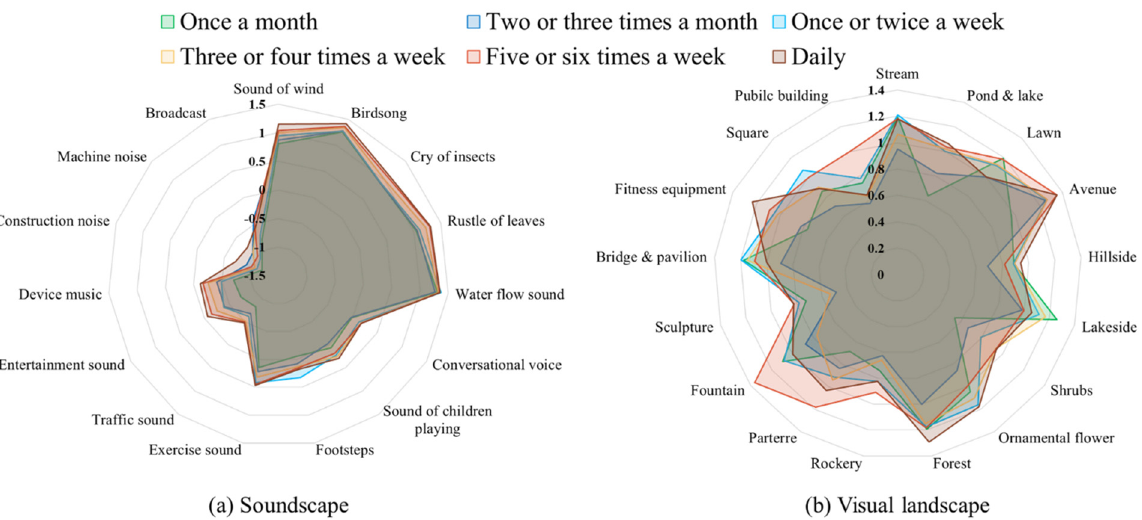
Figure 10. Radar map of soundscape ( a ) and visual landscape ( b ) preferences distribution of exercisers at different exercise frequencies.